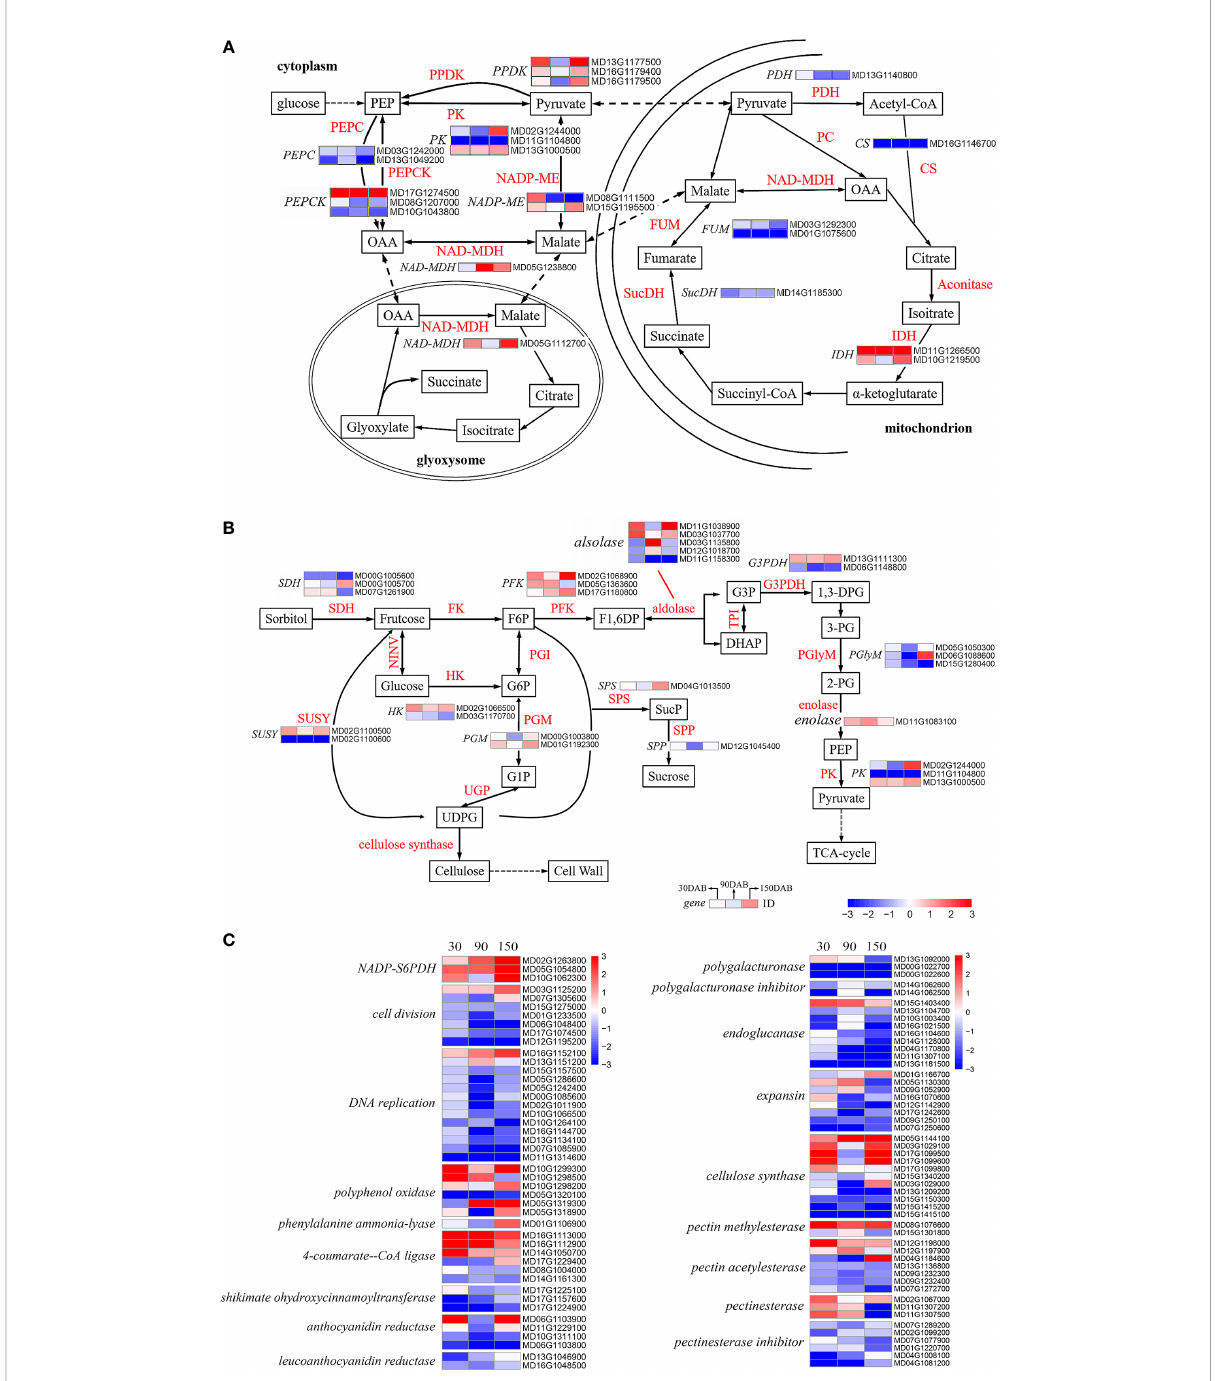
FIGURE 7 Analysis of the differentially expressed genes associated with metabolic pathways in ‘ HanFu ’ and ‘ Huahong ’ . (A) The metabolic pathways of glucose for major acids (malic acid, fumaric acid, citric acid, succinic acid, oxalic acid) in apple fruit. (B) The metabolic pathways of glucose, fructose, sorbose, and sucrose in apple fruit. (C) A heat map of differentially expressed genes (DEGs) involved in cell wall synthesis and genes encoding other genetic regulatory pathways. A heatmap showing log2-Fold changes of DEGs ( ‘ HanFu ’ vs. ‘ Huahong ’